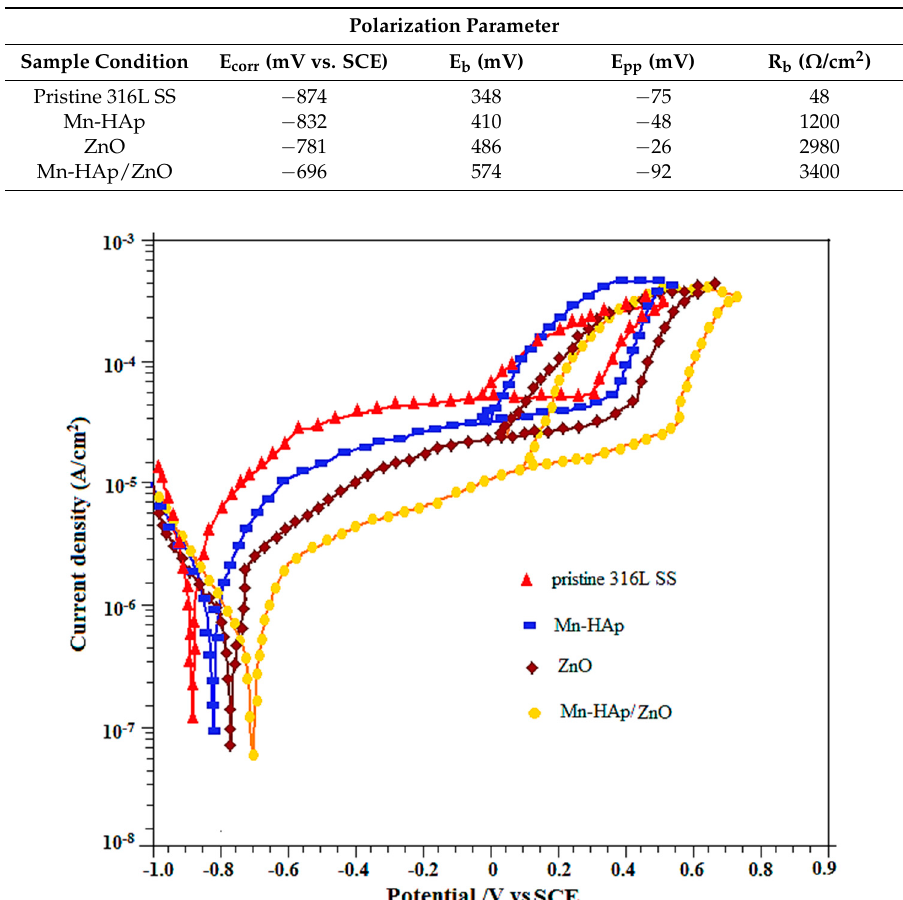
Figure 7. Potentiodynamic cyclic polarization curves of pristine 316L SS, and Mn-HAp, ZnO, and Mn-HAp/ZnO bilayer coating on 316L SS in simulated body fluid (SBF) solution.